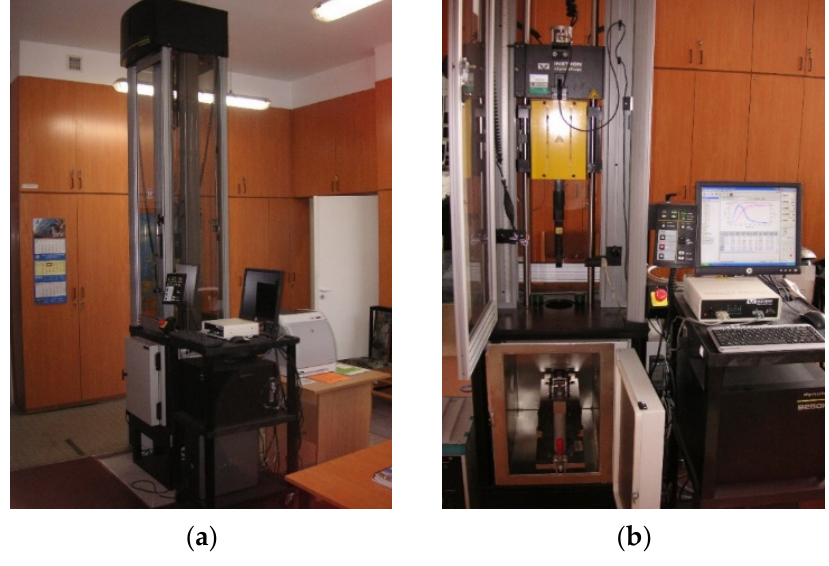
Figure 3. Post view: ( a ) side; ( b ) front.